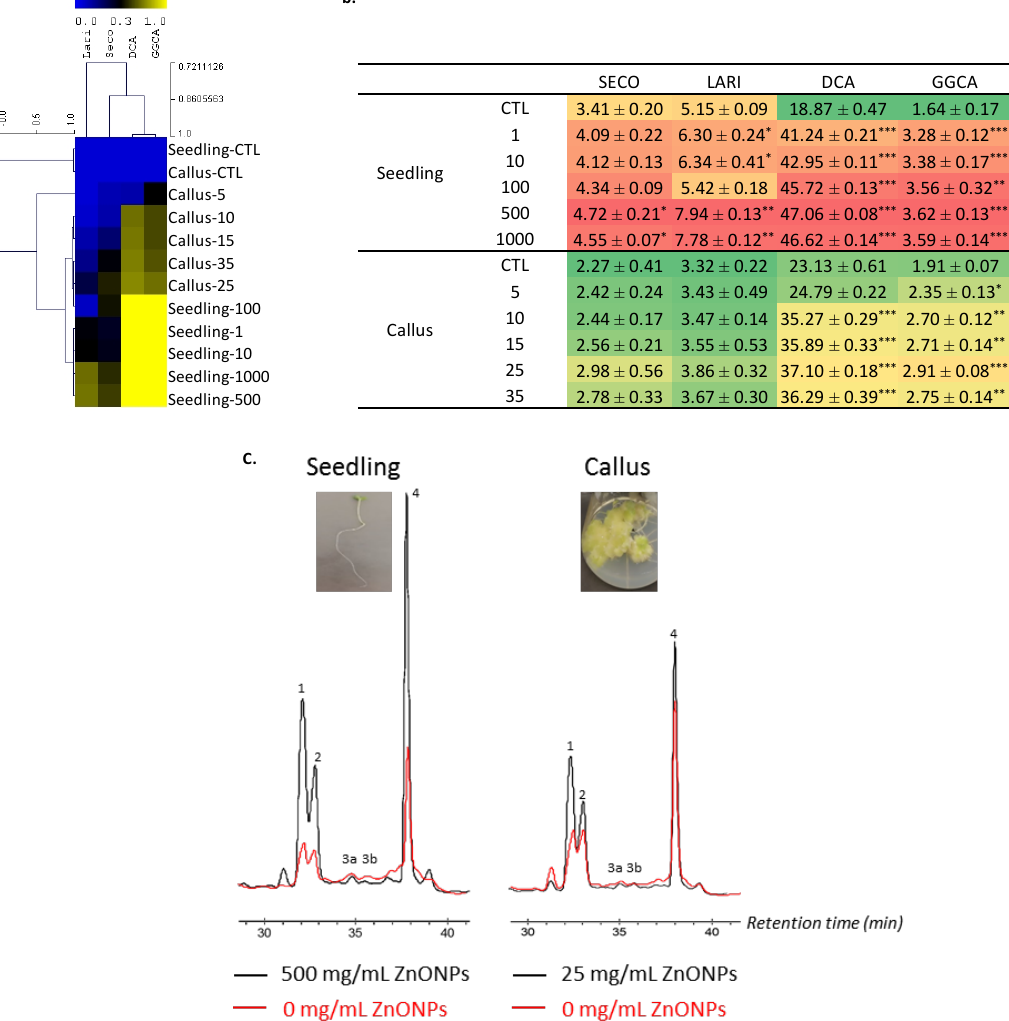
Figure 5. Influence of the different concentrations of ZnONPs on (neo)lignans biosynthesis in the seedlings and the stem-derived callus of L. usitatissimum. ( a ) The hierarchical clustering analysis of the (neo)lignans production; ( b ) the actual values of the (neo)lignans accumulation (in mg/g DW); ( c ) the typical HPLC chromatograms of the control and the ZnONP-treated flax seedling and stem-derived callus. Values are means ± SD of three independent experiments; * p < 0.05, ** p < 0.01, *** p <